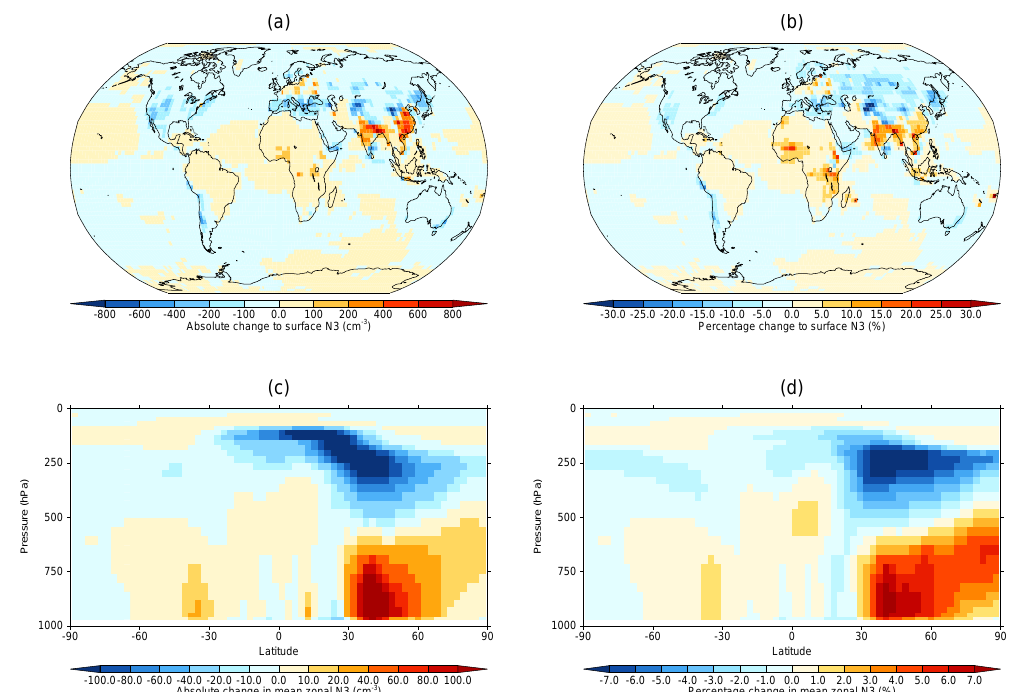
Figure 11. Simulated absolute and percentage change in annual mean surface (a–b) and zonal (c–d) number concentration ( N 3 ; greater than 3nm dry diameter) due to residential emissions (res_base), relative to an equivalent simulation where residential emissions have been removed